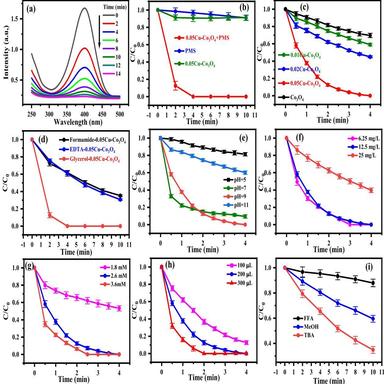
Catalytic performances of Cu2+-Co3O4/NC materials toward advanced oxidation reaction of PNP by PMS. Typical UV–vis spectra for the advanced oxidation of 4-NP by using PMS (1.8 mM) as oxidation agent (a), Ct/C0 of PNP in different PMS, 5%Cu2+-Co3O4/NC-glycerol-600, and 5%Cu2+-Co3O4/NC-glycerol-600+PMS reaction systems (b), Ct/C0 of PNP in different Co3O4/NC-glycerol-600+PMS, 1%Cu2+-Co3O4/NC-glycerol-600+PMS, 2%Cu2+-Co3O4/NC-glycerol-600+PMS, 5% Cu2+-Co3O4/NC-glycerol-600+PMS system (c), degradation of PNP in